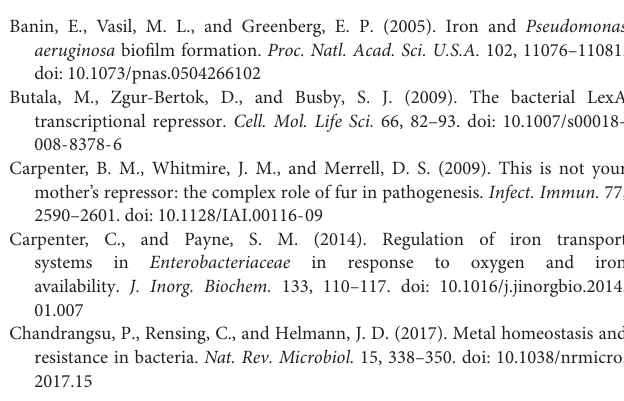
FIGURE S1 | Protein sequence alignments between E. faecalis Fur (EF1525) and Fur archetypes from different bacterial species. Color circles denote conserve motif involved in iron/zinc binding. FIGURE S2 | Growth curve of E. faecalis wild type and (cid:49) fur under different conditions of iron exposure (excess and deficiency) in three biological replicates (Mann–Whitney test, p < 0.05). Error bars represent standard deviation (SD) values. TABLE S1 | Differentially expressed genes in E. faecalis wild type and (cid:49) fur . The table shows the differentially expressed genes obtained from the RNAseq experiments. TABLE S2 | Global transcriptional regulatory network activated by iron deficiency or excess in E. faecalis wild type and (cid:49) fur . DATA SHEET S1 | RNAseq complete